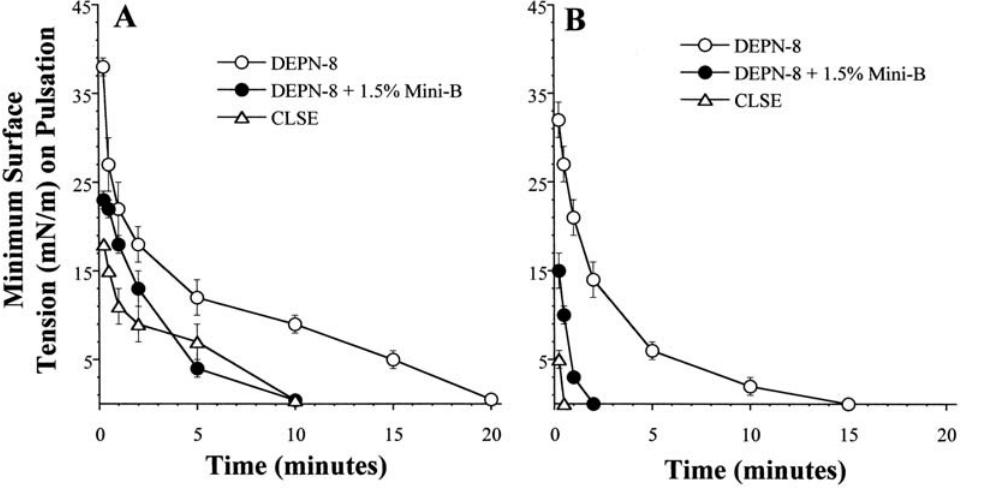
Figure 3. Dynamic surface activity of DEPN-8 + 1.5% (by wt) Mini-B compared to CLSE on the pulsating bubble surfactometer. Panel A: 0.5 mg/ml phosphonolipid (phospholipid); Panel B: 2.5 mg/ml phosphonolipid (phospholipid). Surface tension at minimum bubble radius (minimum surface tension) for DEPN-8 + 1.5% Mini-B and CLSE is graphed as a function of time on a pulsating bubble surfactometer (37 u C, 20 cycles/min, 50% area compression). Data are Mean 6 SEM for n=3–5. See text for